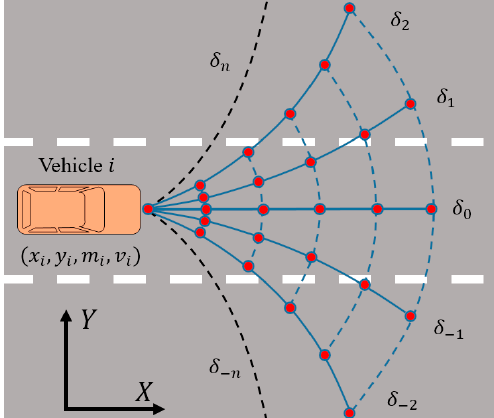
Figure 2. Trajectories based on the steering angle. δ i denotes the steering angle corresponding to each predictive trajectory. The black dashed line is the predictive trajectory corresponding to the left and right limit steering angle, which is related to the vehicle speed and road conditions